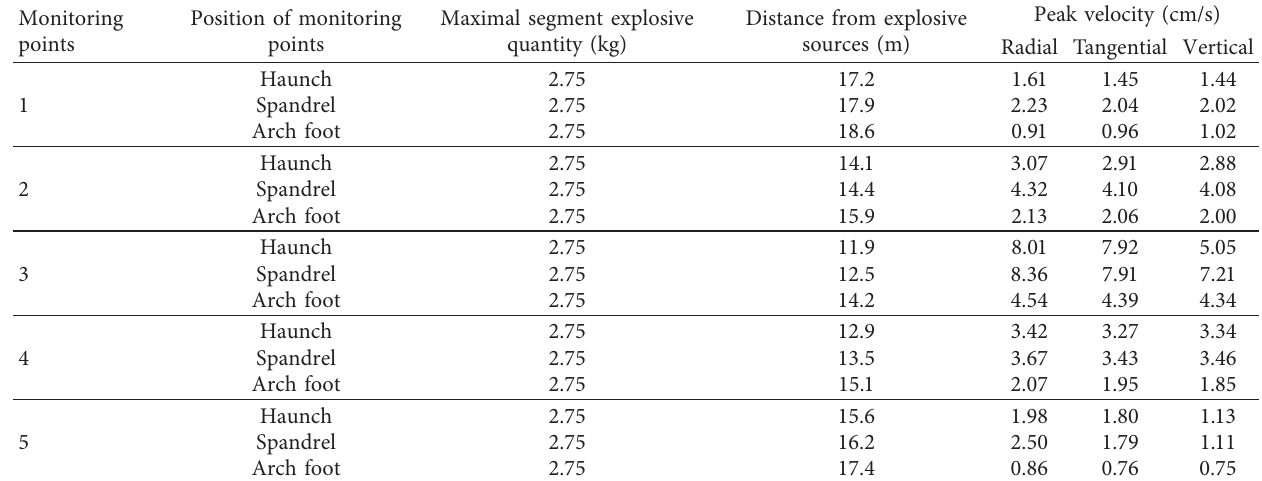
Table 2: Monitoring data of blasting-induced vibration at different